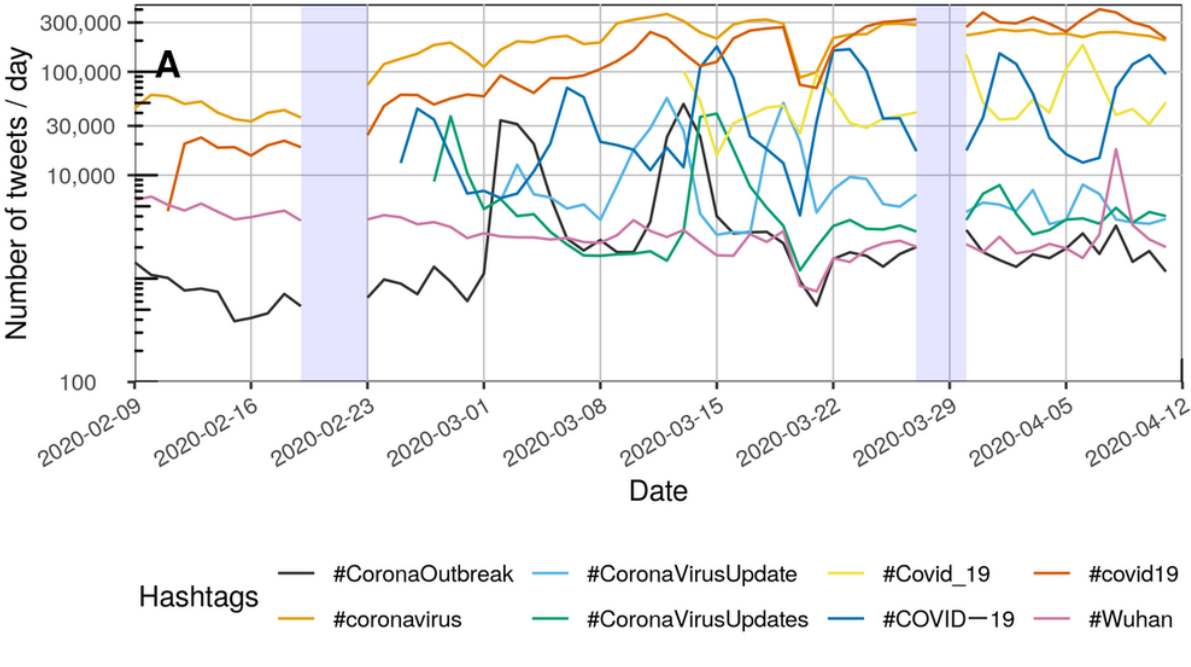
Figure 2. Number of tweets per day for the hashtags ranked 1-8 (see Table 2) between February 9, 2020, and April 11, 2020, on a logarithmic scale. The capital letter "A" represents the naming of the disease by the World Health Organization on February 11, 2020. Blue rectangles: No tweets were collected between February 20 and 22 as well as between March 28 and 29 due to technical issues.